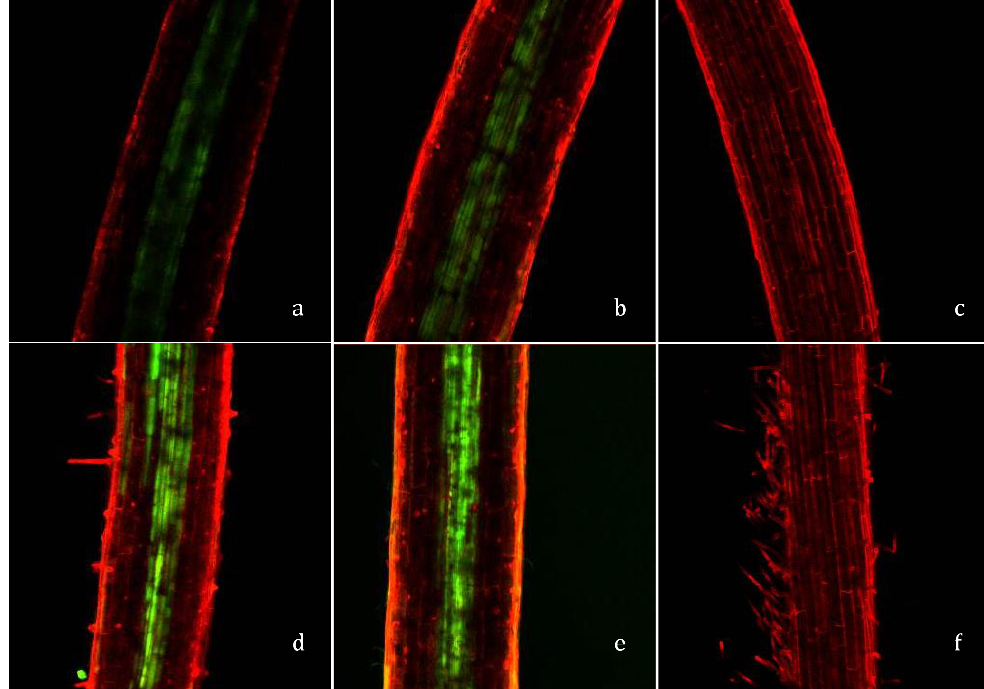
Figure 5. Confocal laser-scanning microscope images of spinach roots of ( a ) control (unprimed) seedlings, ( b ) water- primed seedlings, ( d , e ) 6 mM and 10 mM Zn-primed seedlings, respectively, and ( c , f ) seedlings treated with 200 µM N,N,N’,N-tetrakis (2-pyridylmethyl) ethylenediamine (TPEN) for 30 min and then exposed to 15 µM Zinpyr-1 for 5 h.